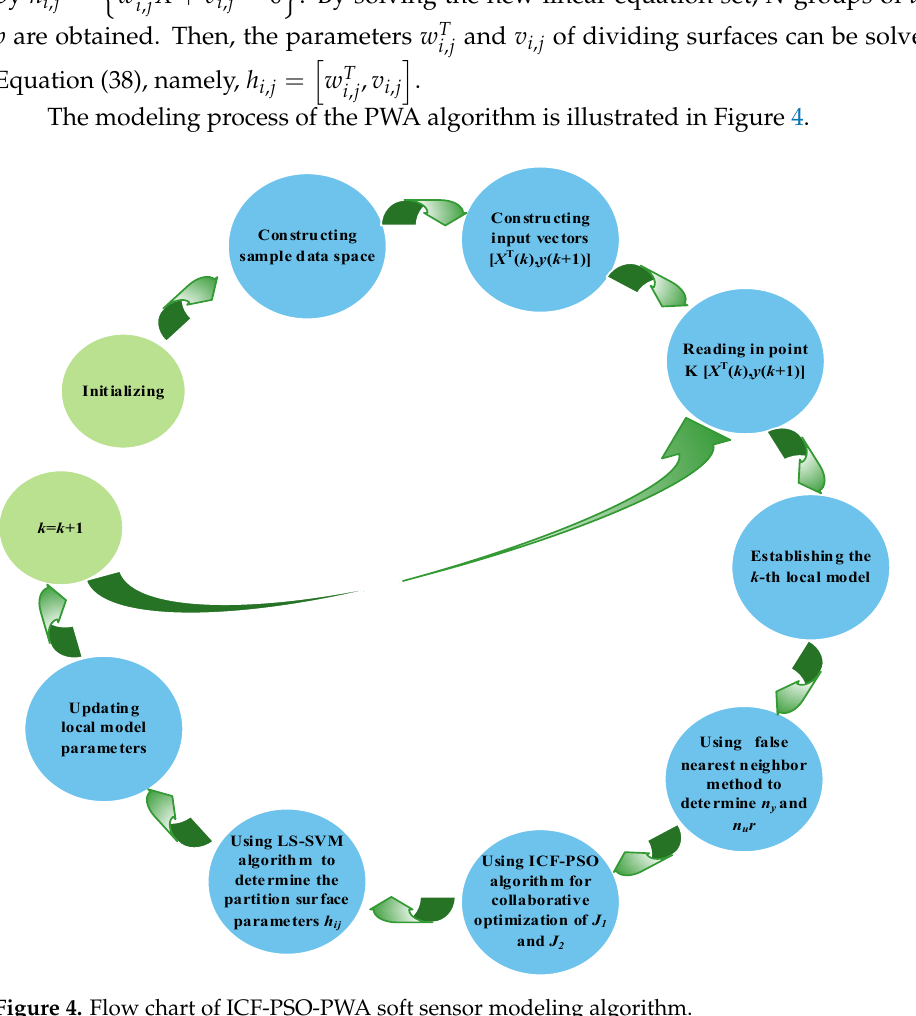
Figure 4. Flow chart of ICF-PSO-PWA soft sensor modeling algorithm.